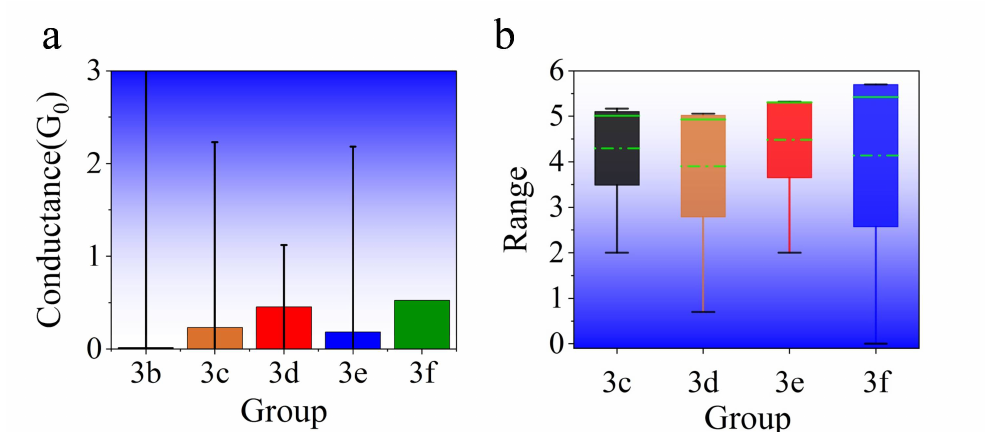
Figure 5. ( a ) Comparison of average conductance among defect models and variance of vacancies in each group. The black line shows the difference of variance; ( b ) box plot of positions distribution in each group. The green dotted line shows the mean value, and the solid line shows the median